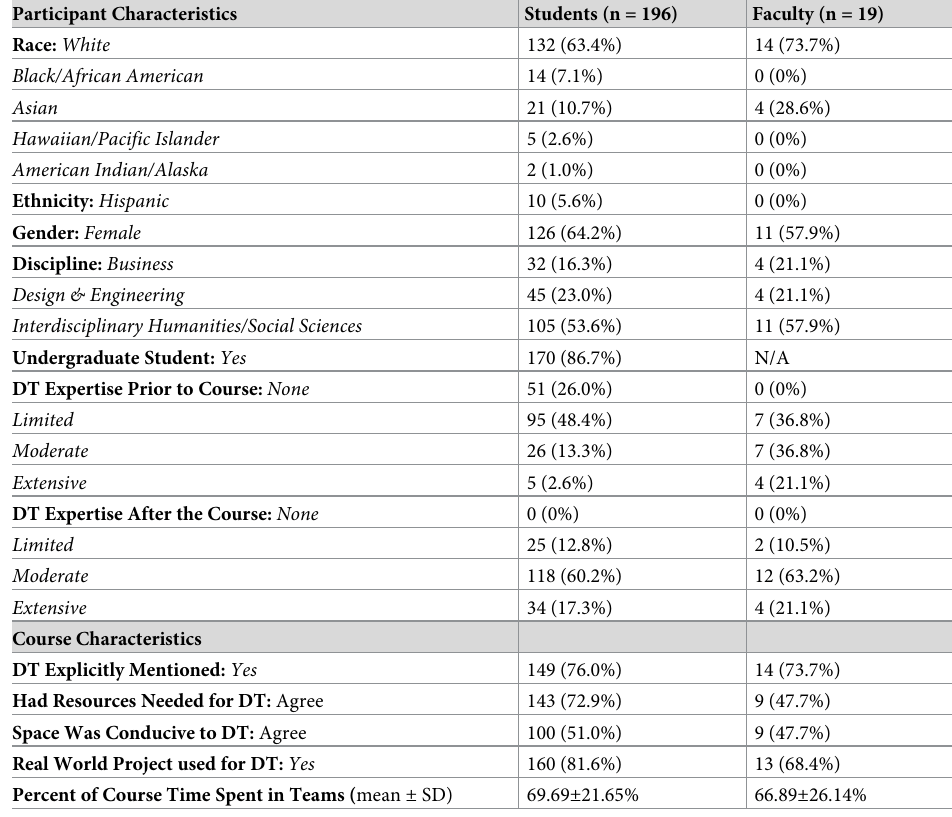
Table 1. Characteristics of survey participants and courses. Participant